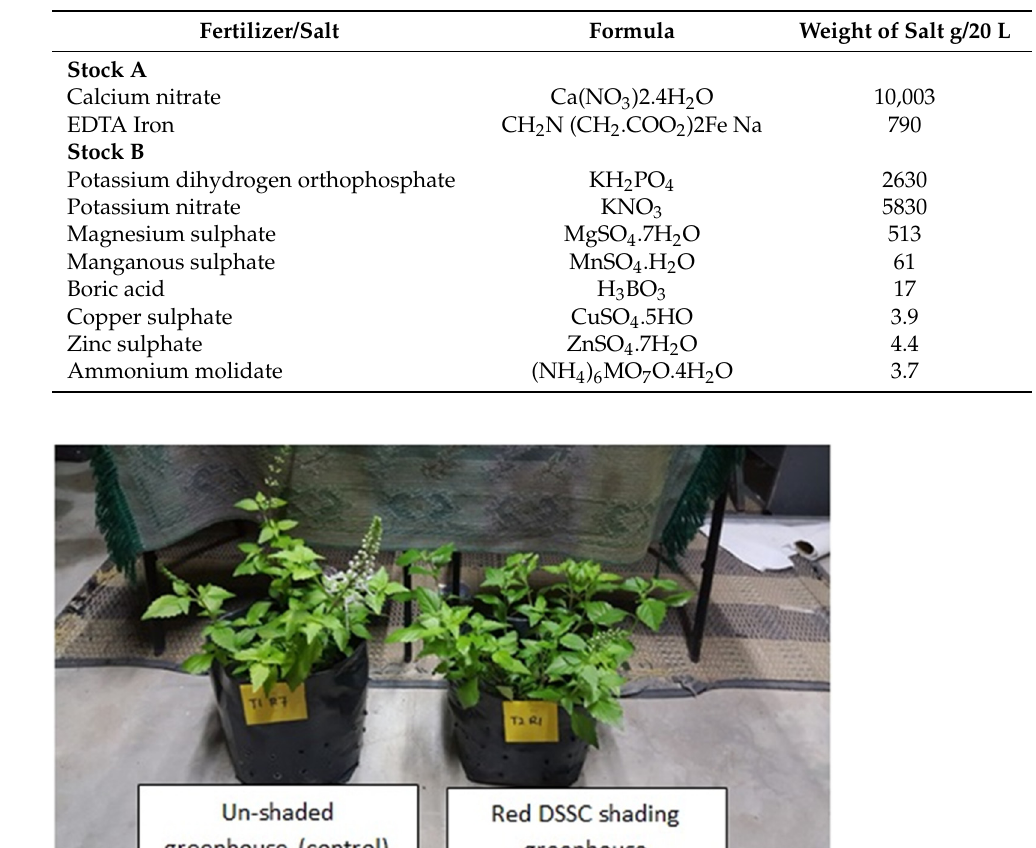
Table A1. Nutrient solution formulation and chemical characteristics applied in the study [92].